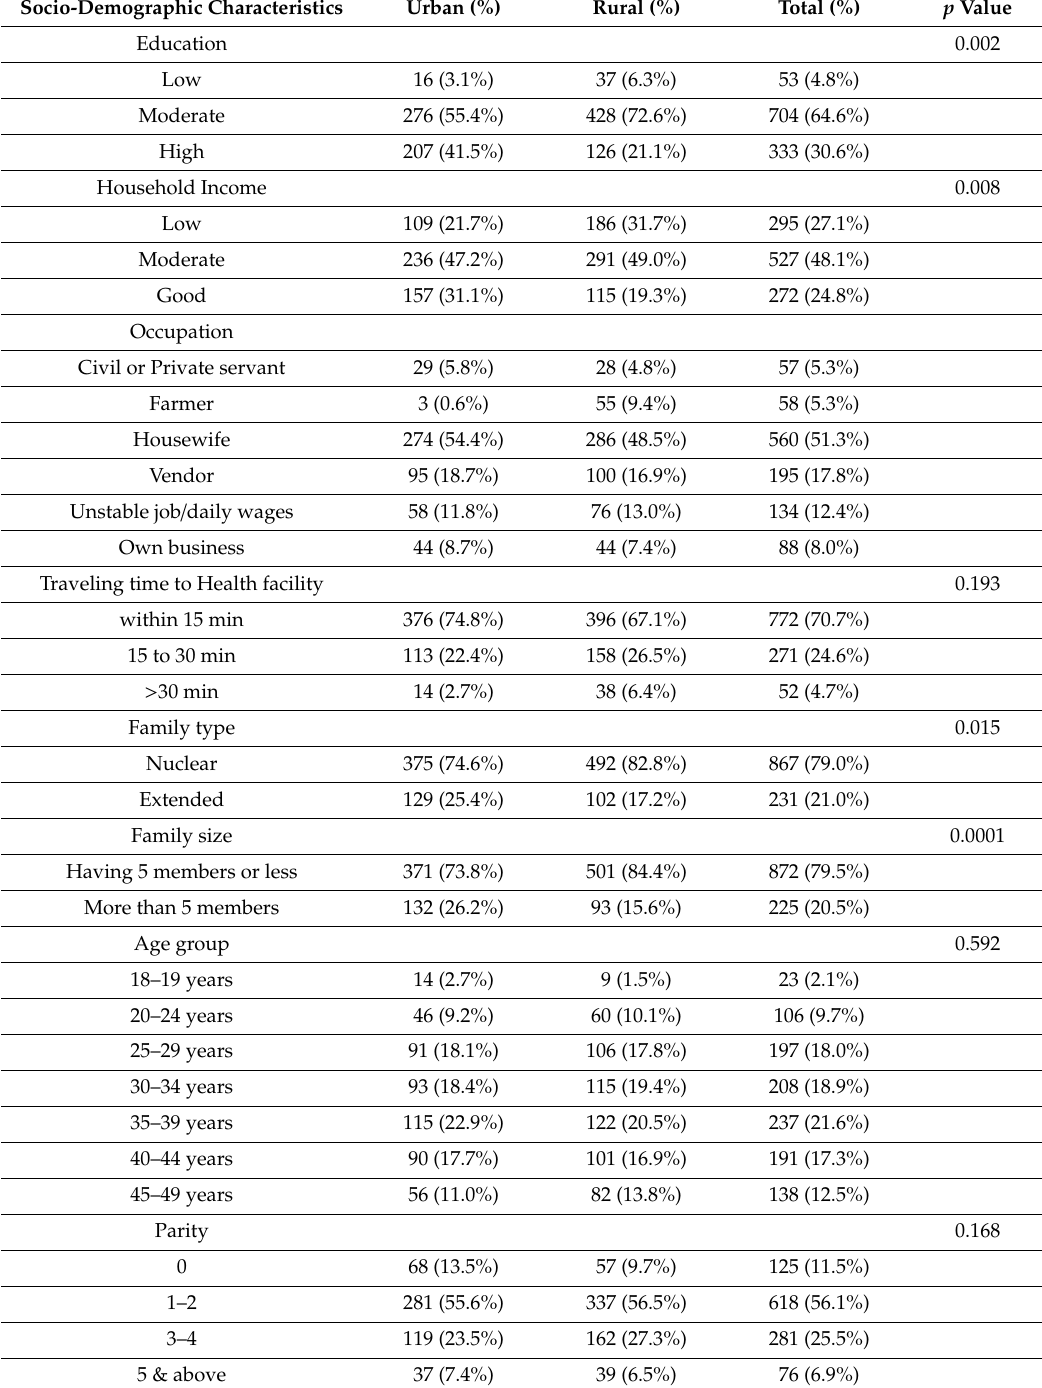
Table 1. Socio-demographic indicators by urban-rural residence among 18–49-year-old currently married women in south and north